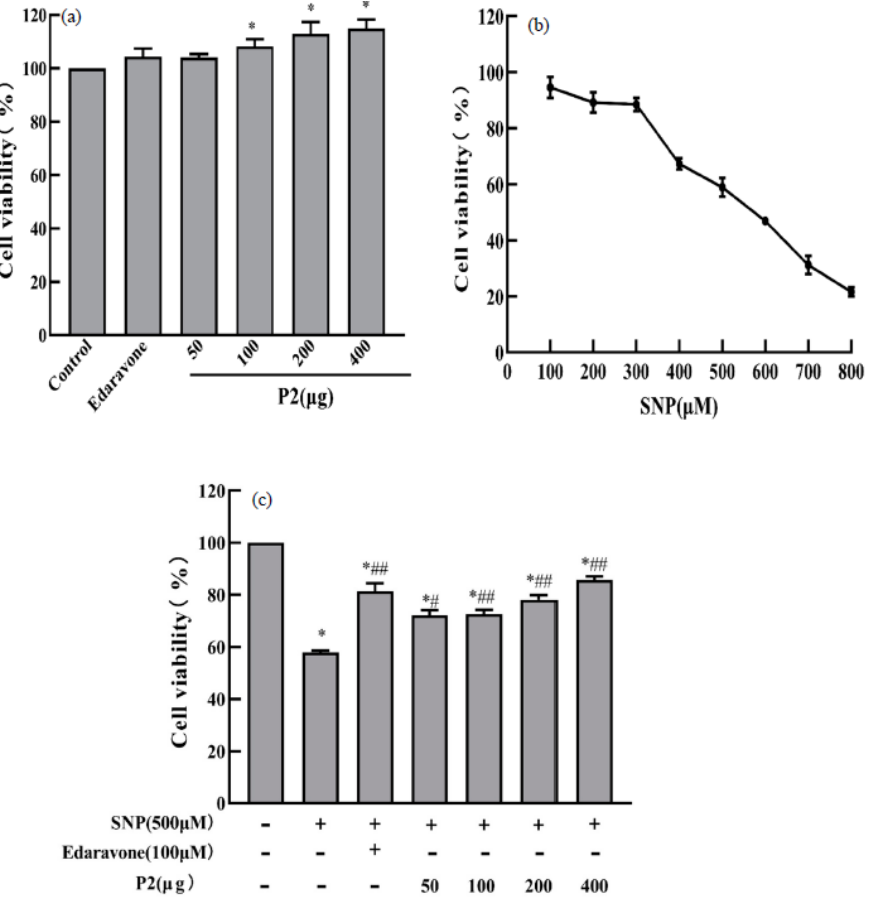
Figure 8. Cytotoxicity of P2 fraction from hydrolysate of EBN by-products in PC12 cells ( a ); damage effect of SNP on PC12 cells ( b ); protective effects for the P2 fraction against SNP-induced oxidative damage on PC12 cells ( c ). The data indicated as means ± SD ( n = 3). * p < 0.05 vs. the control group. # p < 0.05 vs. the SNP stimulated group. ## p < 0.01 vs. the SNP stimulated group.